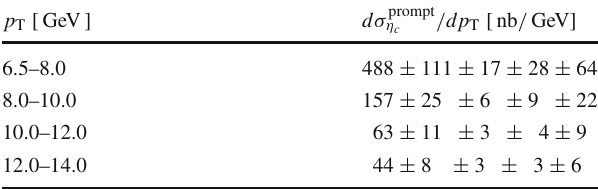
Table 6 Differential η c prompt production